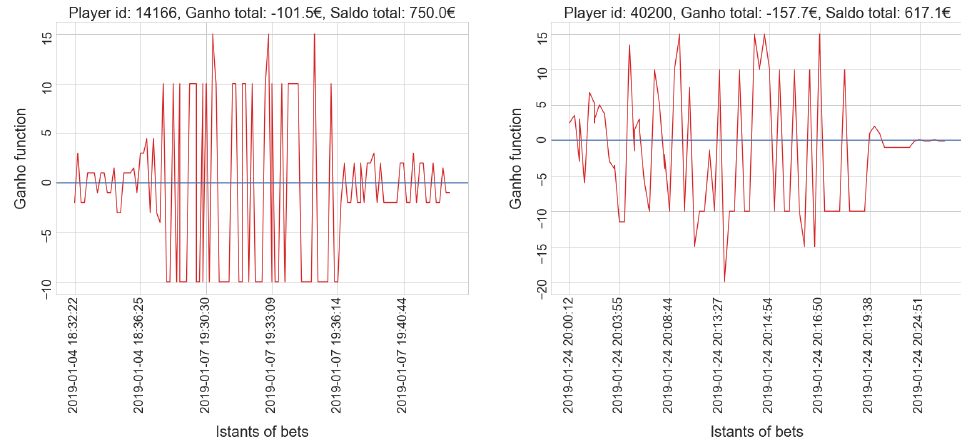
Figure 19. Time series plot of two players in Cluster 0.